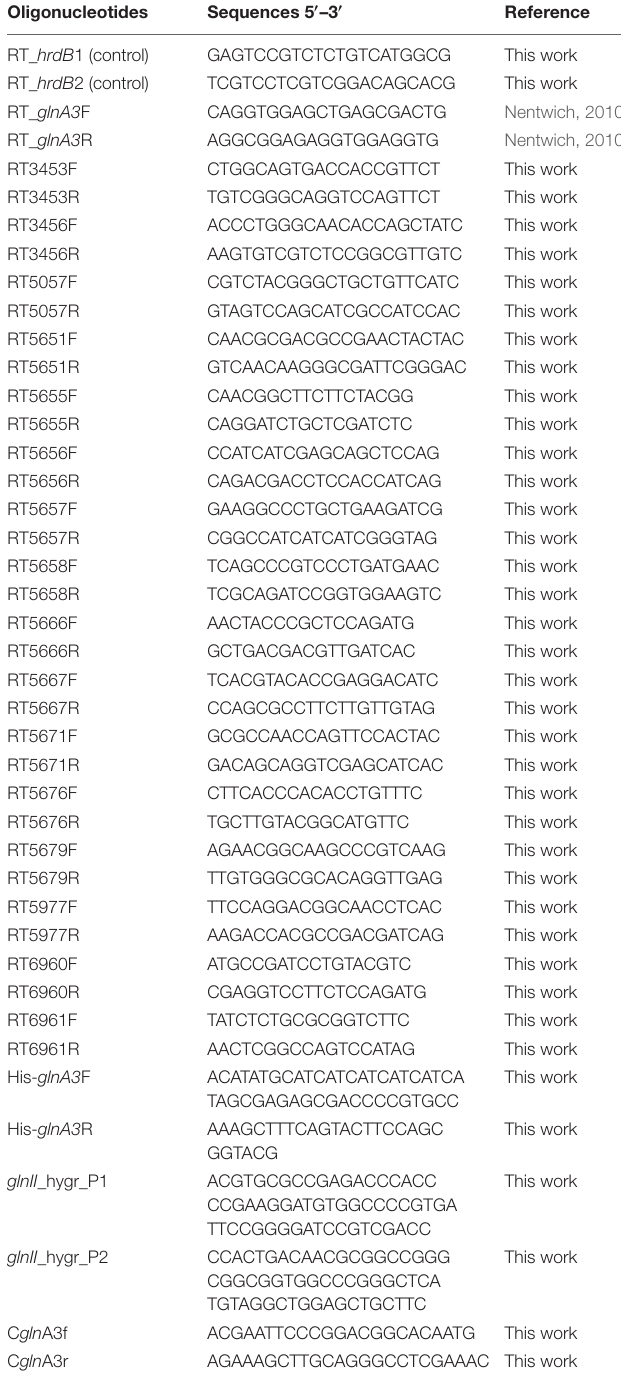
TABLE 2 | Oligonucleotides used in this